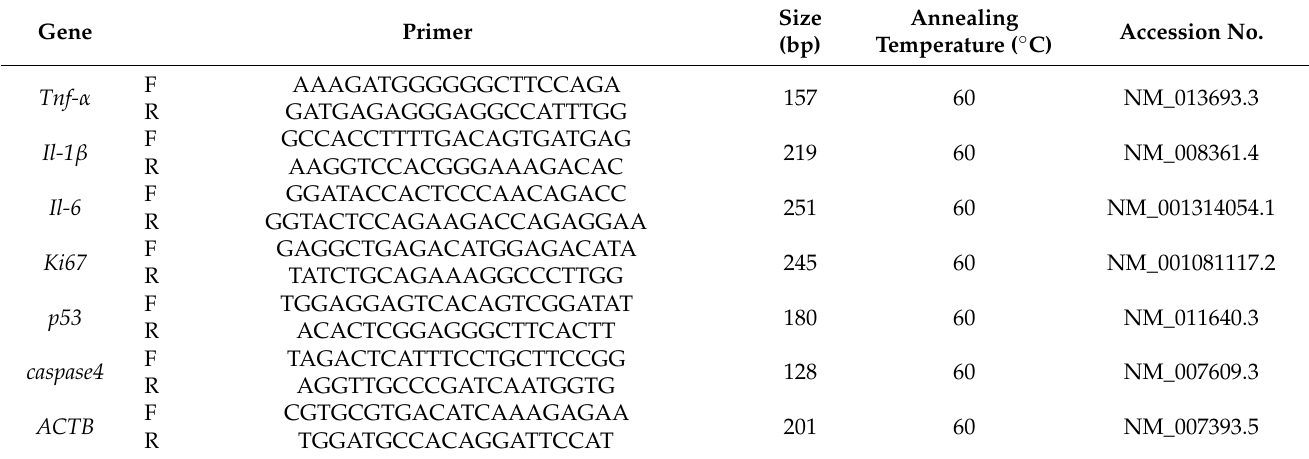
Table 1. Primer pairs used in the gene expression analysis.